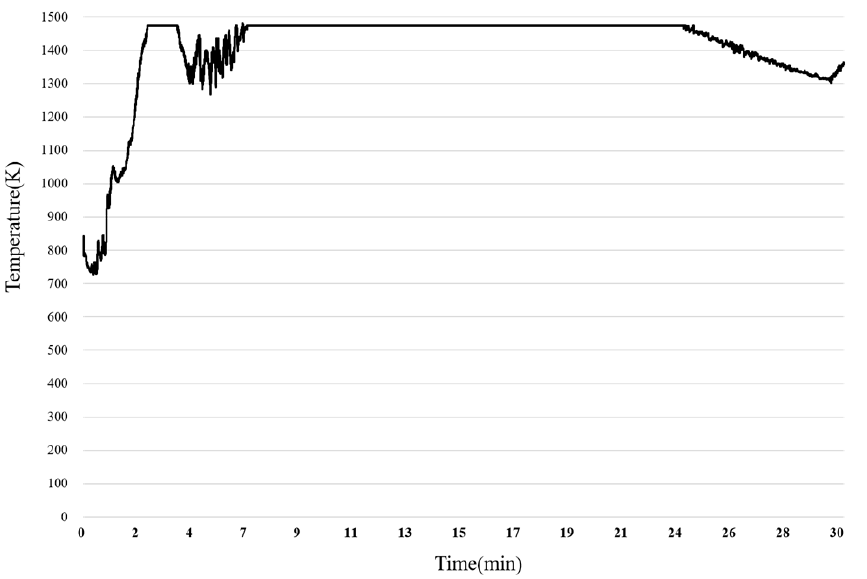
Figure 11. Temperature changes during the magnesium powder combustion. Figure 12 describes the combustion process of magnesium powder depending on the elapsed time. Immediately after igniting the material, the combustion was slowly launched with pink flames. Since 180 s, drastic fire spread accompanied by the bright white flames were observed that produced gases through the dynamic combustion. This magnesium powder combustion on the surface mainly remained by-products appearing white color. The combustion without flames continued inside of the dummy of the powder. While the significant reaction was burning with flames for 360 s (Figure 12c), the reaction is divided into burning with flames and with melting from 540 s (Figure 12d). Figure 12e indicates clearly separated reactions, burning with flames and without flames in 720 s. Figure 13 shows that there are temperature differences in the areas of the burning with flames and melting. The figure illustrates that the upper side started with the burning surface with flames and turned quickly into the combustion entailing melting reaction. However, but the lower side of the burning point shows delayed combustion reactions with